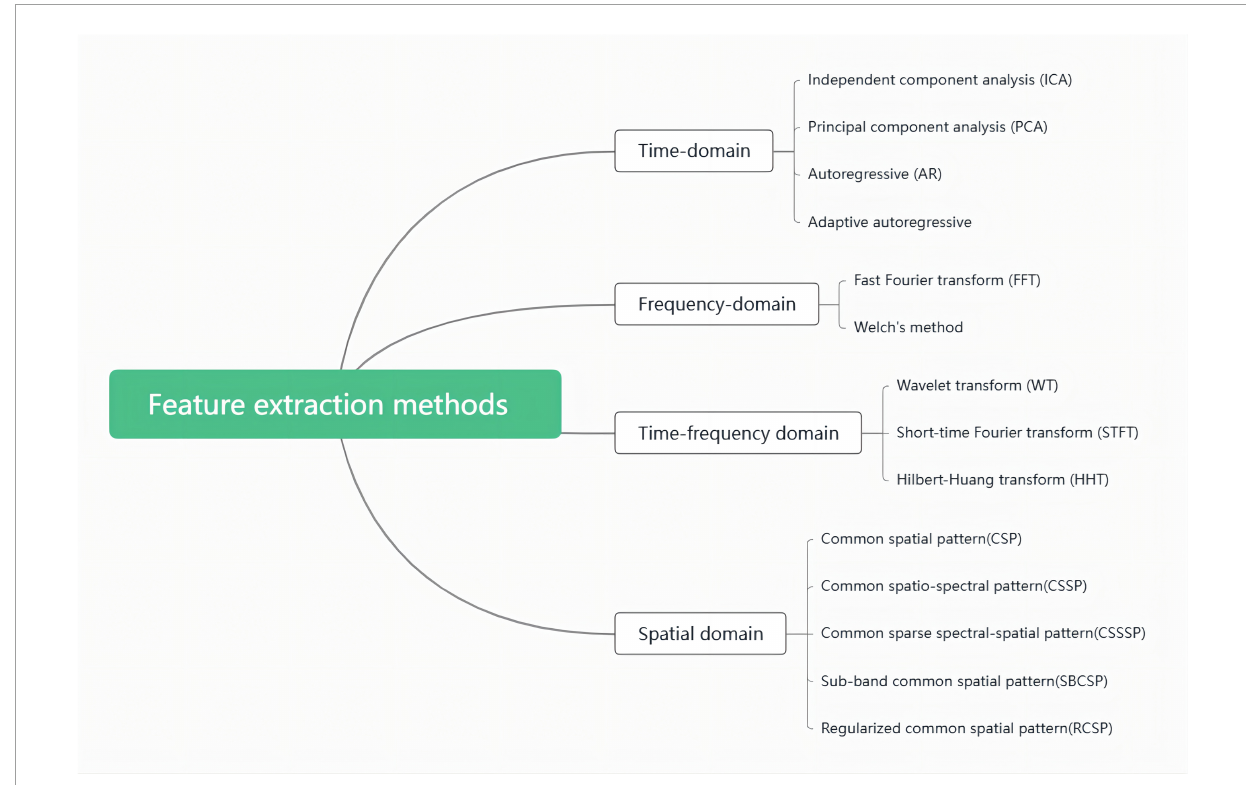
FIGURE1 Feature extraction